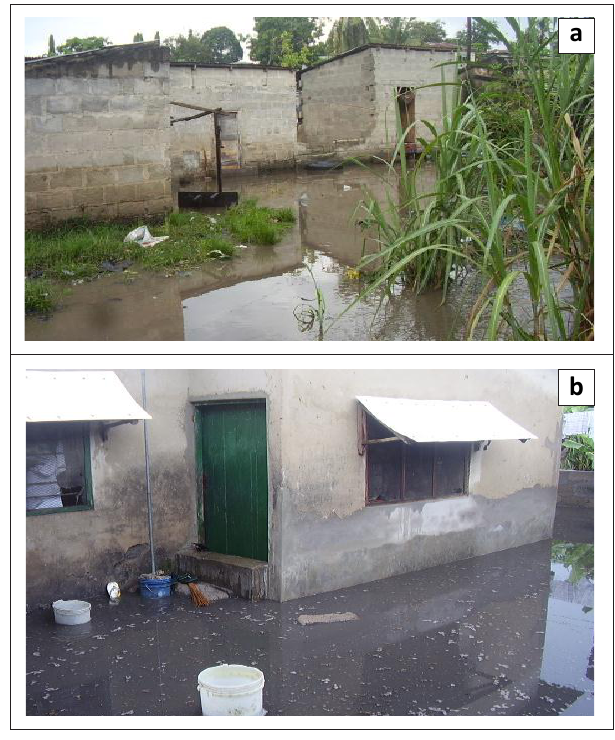
FIGURE 5: Waterlogging (a) and blocked accessibility (b) to FIGURE 5 : Waterlogging (a) and blocked accessibility (b) to houses.